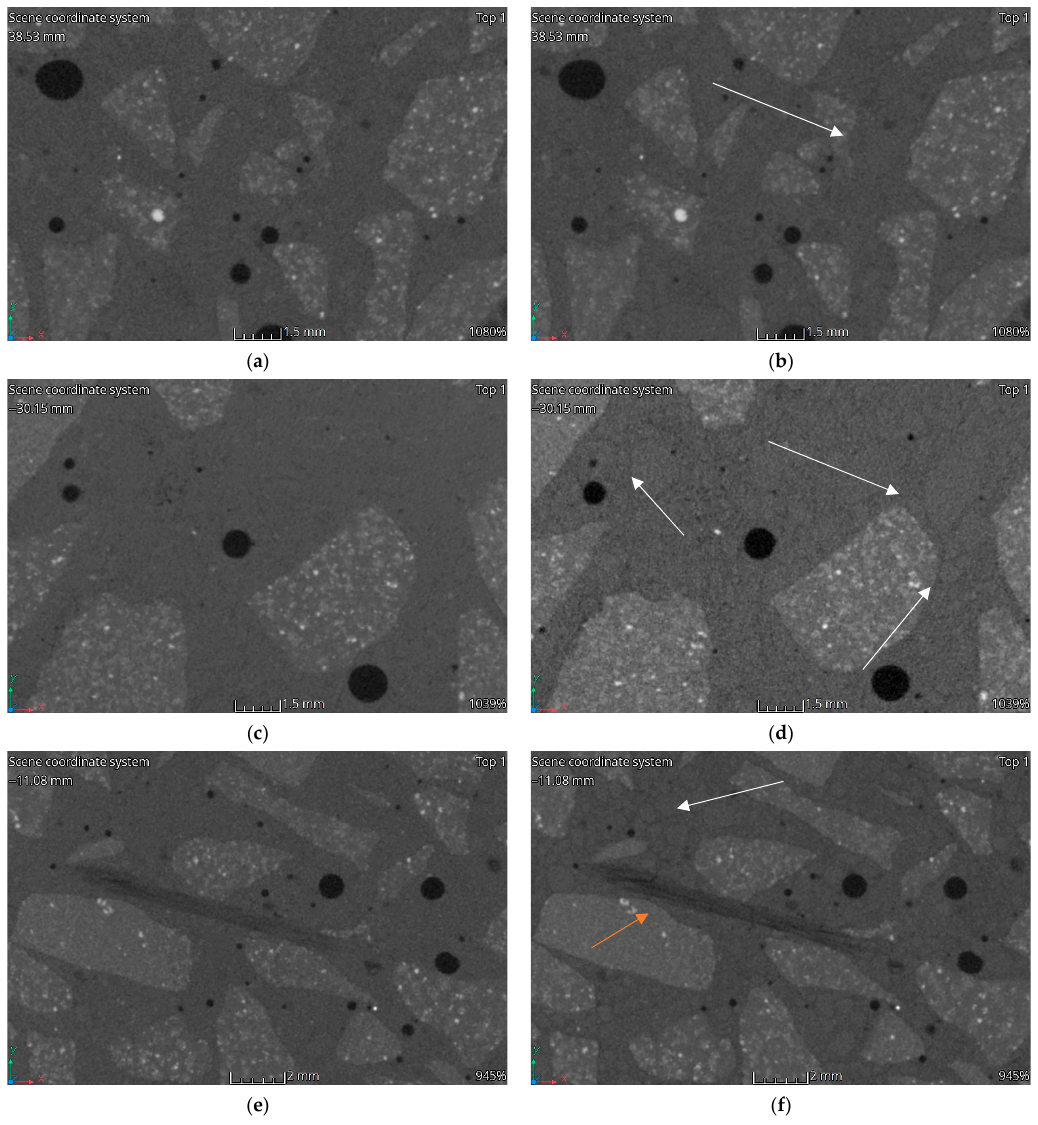
Figure 13. CT imaging results. Structural changes in three samples HPFRC 0.6: ( a ) 20 ◦ C; ( b ) 200 ◦ C; ( c ) 20 ◦ C; ( d ) 400 ◦ C; ( e ) 20 ◦ C; ( f ) 600 ◦ C. During heating, the fine aggregate gradually becomes visible in the matrix. Visually, it stands out through the formation of a dark outline. The dark colour is associated with a local reduction in the density of the material. The authors interpret this phenomenon as a weakening of the adhesion between the aggregate and matrix and, at higher temperatures, the formation of micro-cracks. In Figures 12–15, areas with changes around the fine aggregate are marked with white arrows. A second observation is the formation of air gaps between the aggregate 2–8 and the matrix. These changes are visible in all groups of samples at temperatures above 400 ◦ C. In Figures 12–15, areas with changes around aggregate 2–8 are marked with orange